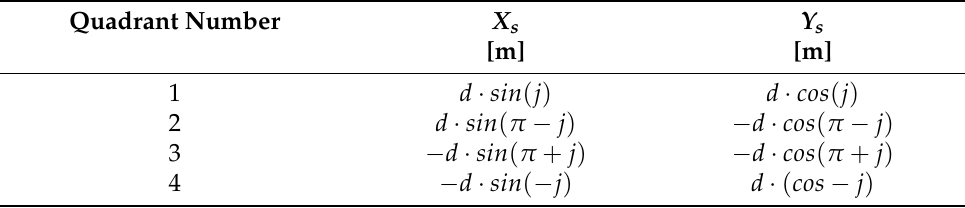
Figure 9. SWAMP reference frame with the dimensions of the sensor located on the platform. Table 4. Equations to compute the shifts on X and Y axes taking into consideration the orientation of SWAMP with respect to the real North. d and j represent the difference in distance between the GPS antenna position and acoustic sensor and the orientation of SWAMP from North,